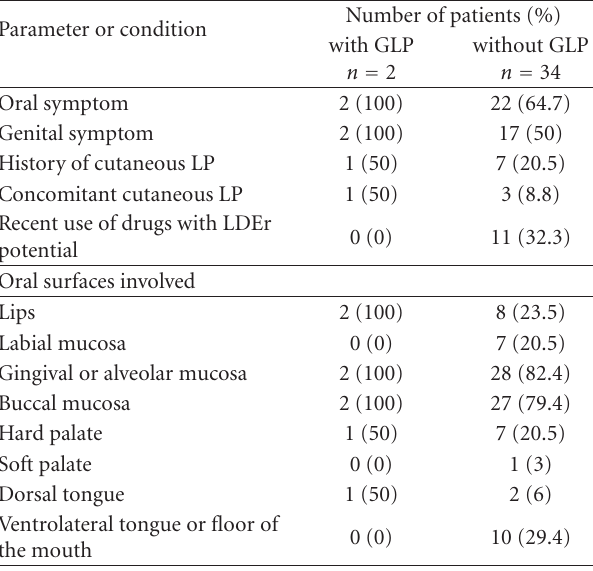
Table 3: Distribution of historical and clinical parameters in OLP patients based on having definite GLP or